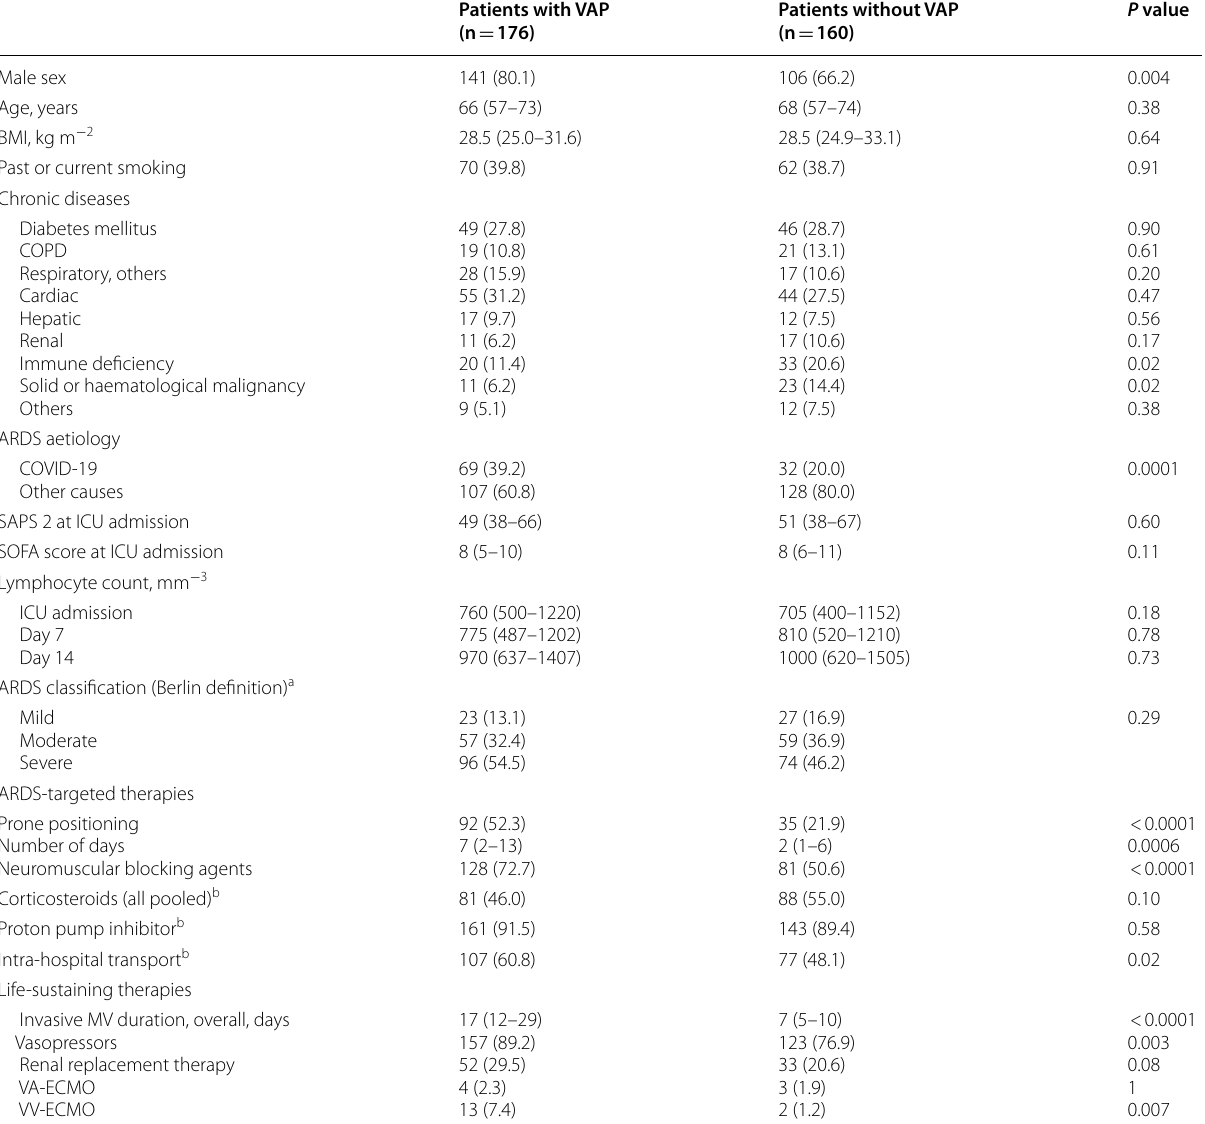
Table 2 Factors associated with the occurrence of